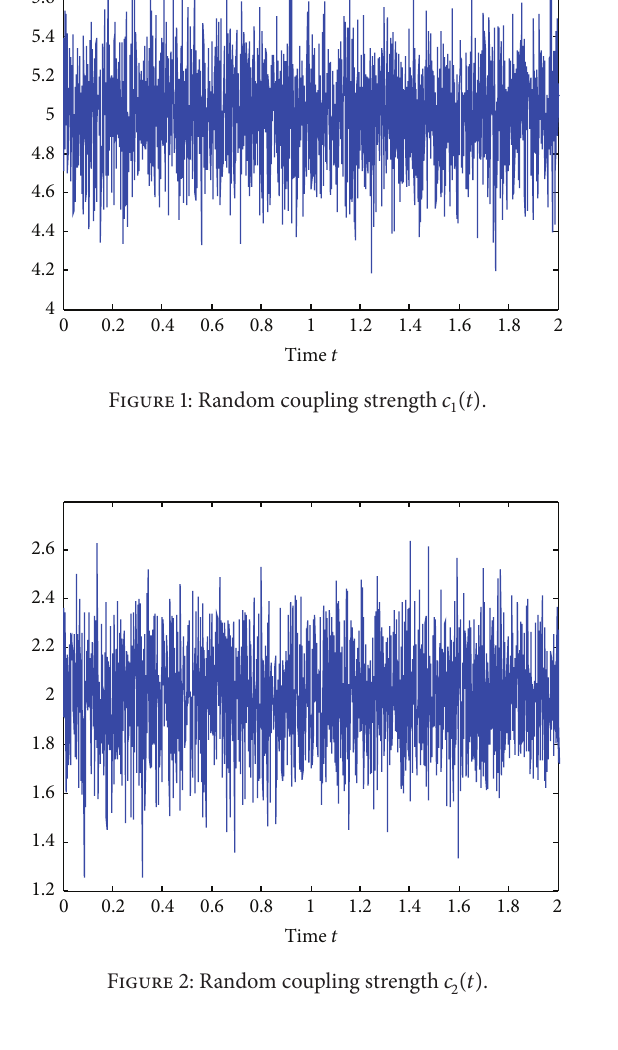
Figure 5: Synchronization error